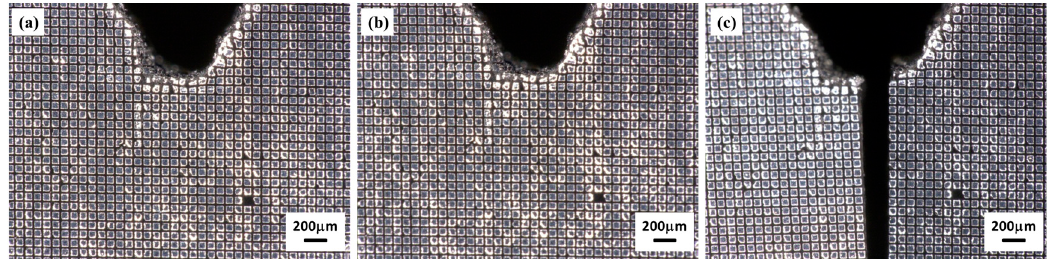
Figure 13. Gratings on the PMMA specimen with a V-shape notch: ( a ) before load, ( b ) under 49.0 N load, and ( c ) under load 73.5 N.